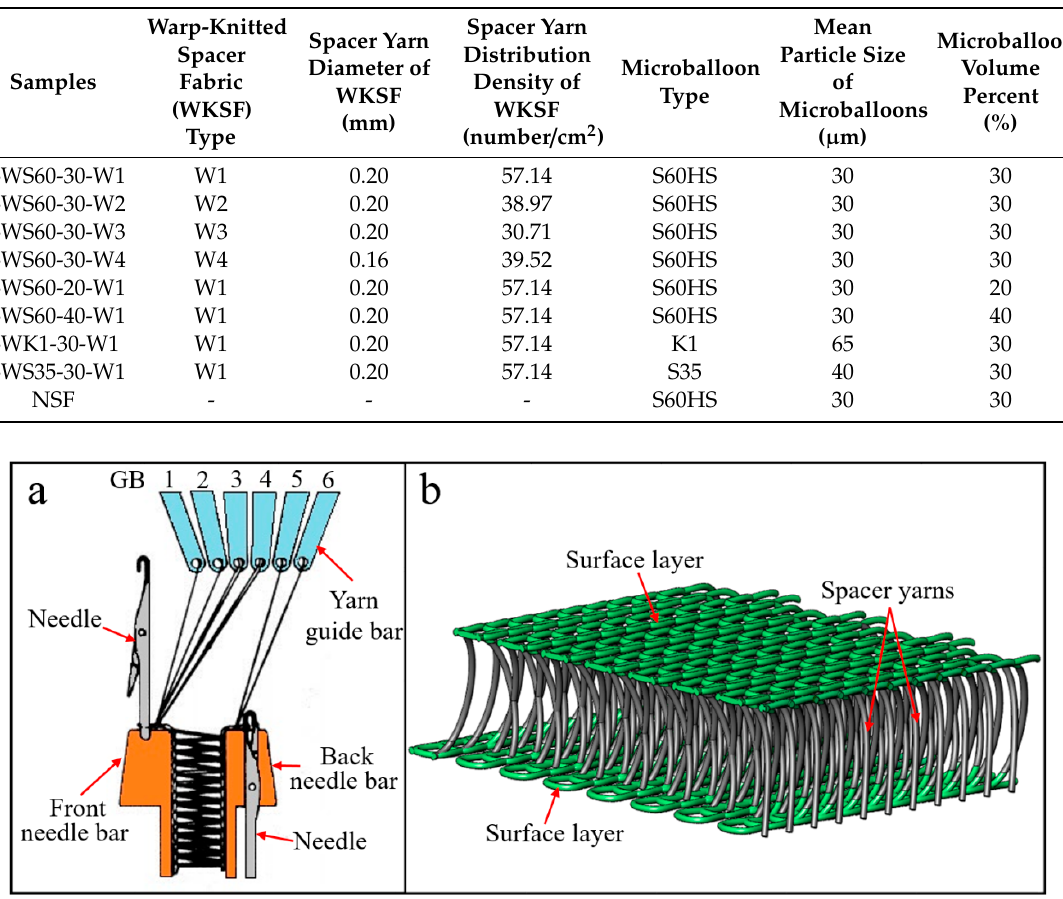
Figure 1. The ( a ) working principle of double-needle-bar warp-knitting machine and ( b ) schematic illustration of warp-knitted spacer fabric (WKSF).